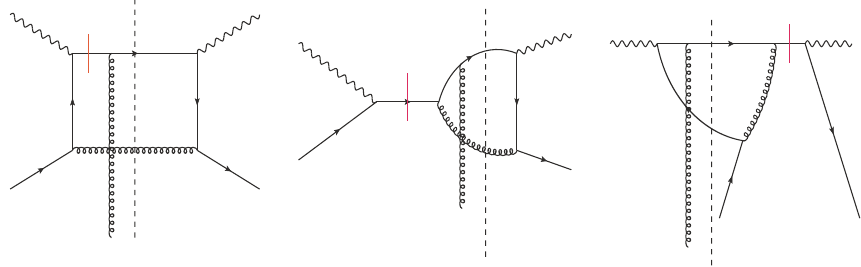
Figure 3: Typical diagrams for soft-gluon pole (left), hard pole (middle), and another hard pole (right). The red barred propagator gives the pole